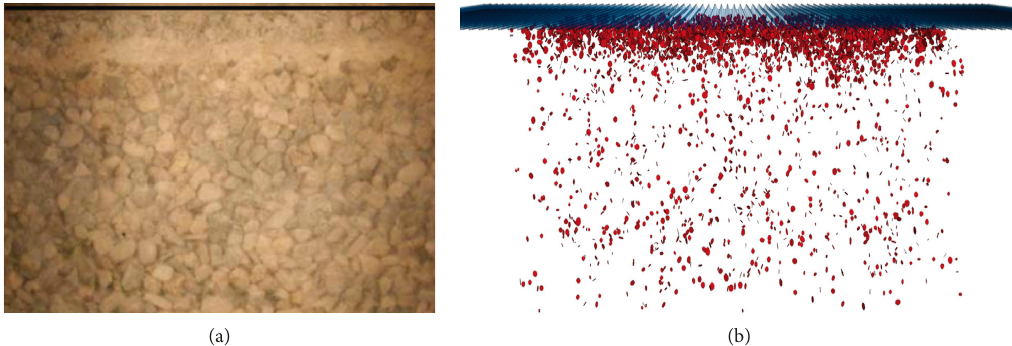
Figure 13: Evolution of the number of agglomerates: (a) absolute; (b) normalized. N a / N a , the normalized number of agglomerates. agglomerates; N a s 0